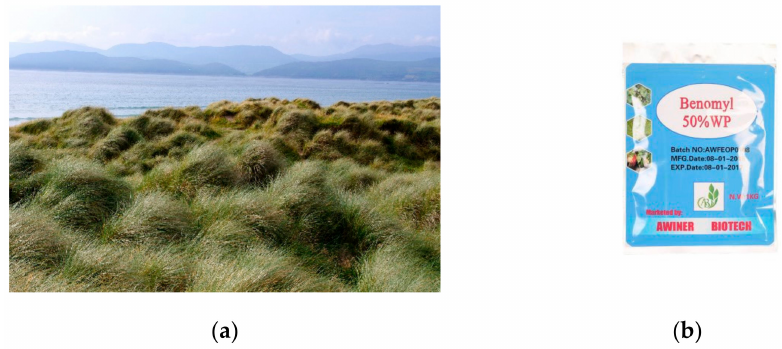
Figure 5. Habitat modification: ( a ) tall grass; ( b )